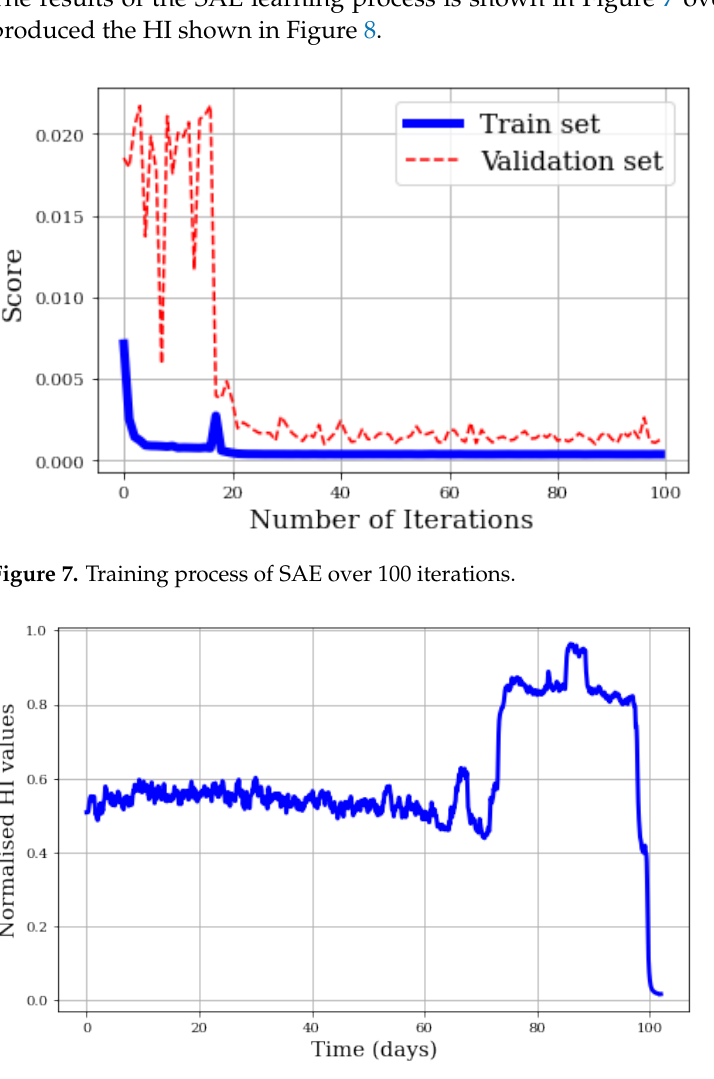
Figure 8. HI produced by the SAE for the whole run-to-failure